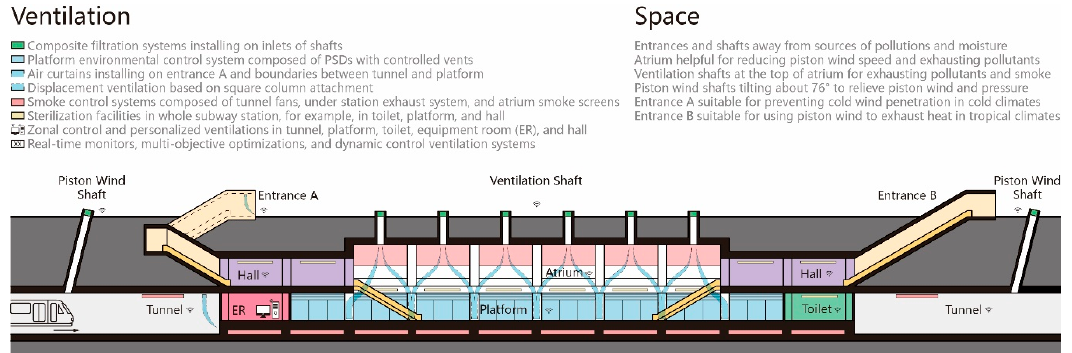
Figure 3. An ideal ventilation and space environment for subway stations.